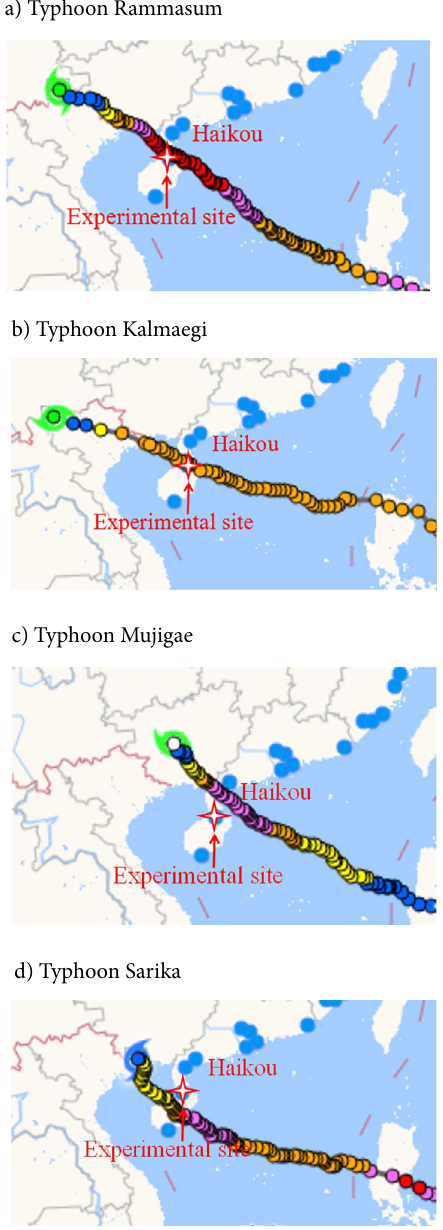
Figure 1. Moving tracks of typhoons Sarika, Mujigae, Kalmeagi, and